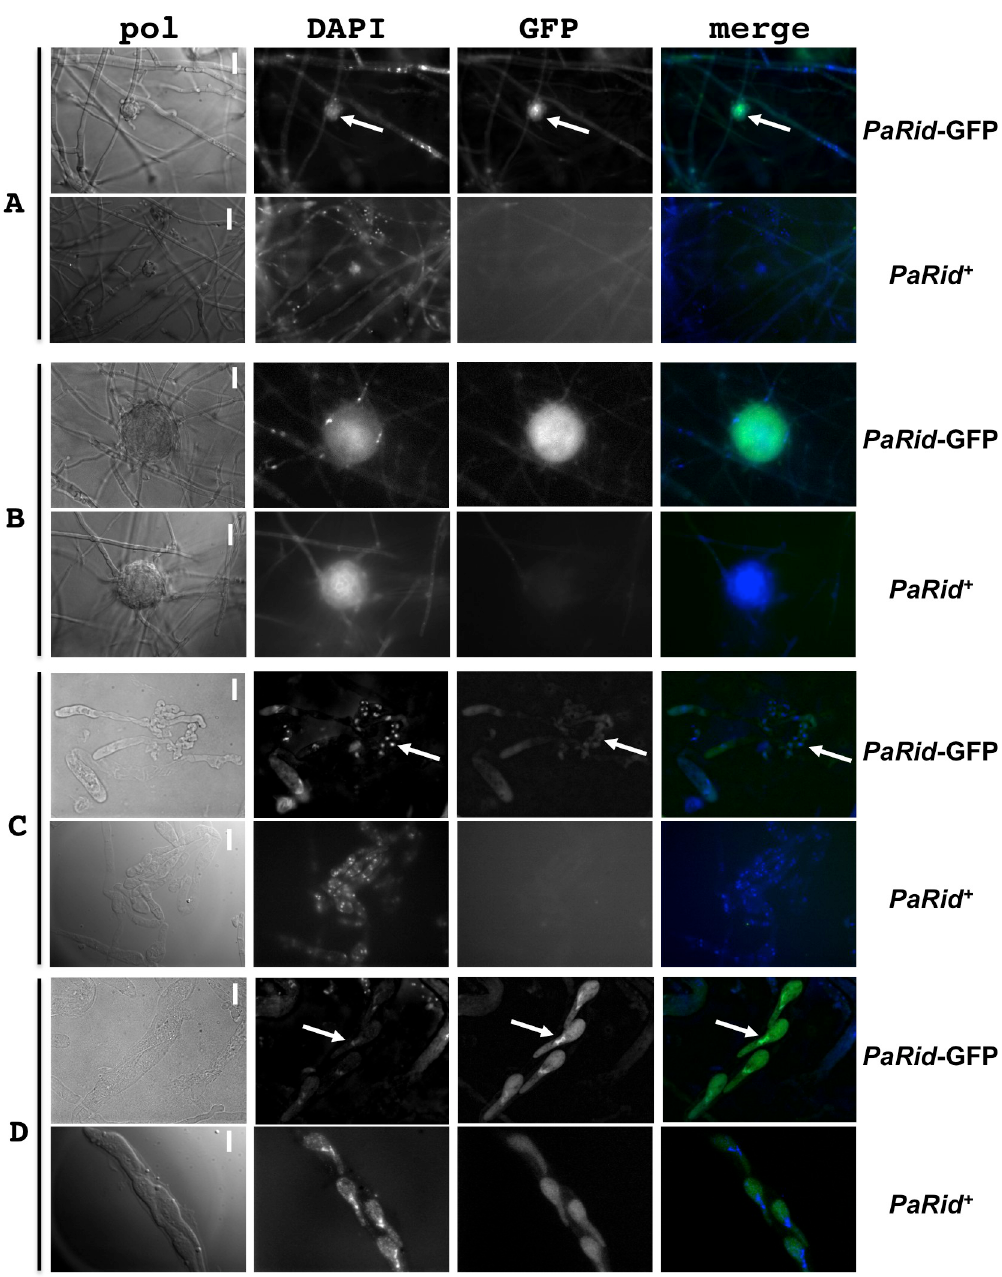
Fig 5. Expression and subcellular localization of PaRid during P . anserina life cycle. PaRid-GFP expression was assayed from a Δ PaRid : AS4 - PaRid -GFP-HA strain showing wild type phenotypes ( PaRid -GFP). As a control, self-fluorescence was assayed from a wild-type strain (No GFP-tagged protein, PaRid + ). No GFP signal can be observed in mycelium, however, a significant and specific GFP signal can be found in ascogonia (A, white arrows are pointing at ascogonia) and protoperithecia (B). Surprisingly, no GFP signal is observed in the croziers (C, white arrows are pointing at croziers) but a strong signal can be noticed in the mature ascospores (D, white arrows are pointing at the nuclei of one ascospore). Since self-fluorescence can be detected in the cytoplasm of ascospores, but not in the nuclei, the PaRid-GFP protein localization is nuclear. From left to right: bright-field (pol), DAPI staining, GFP channel and merge of the two latest. Scale bar: 1,5 μ m (A and B), 5 μ m (C and